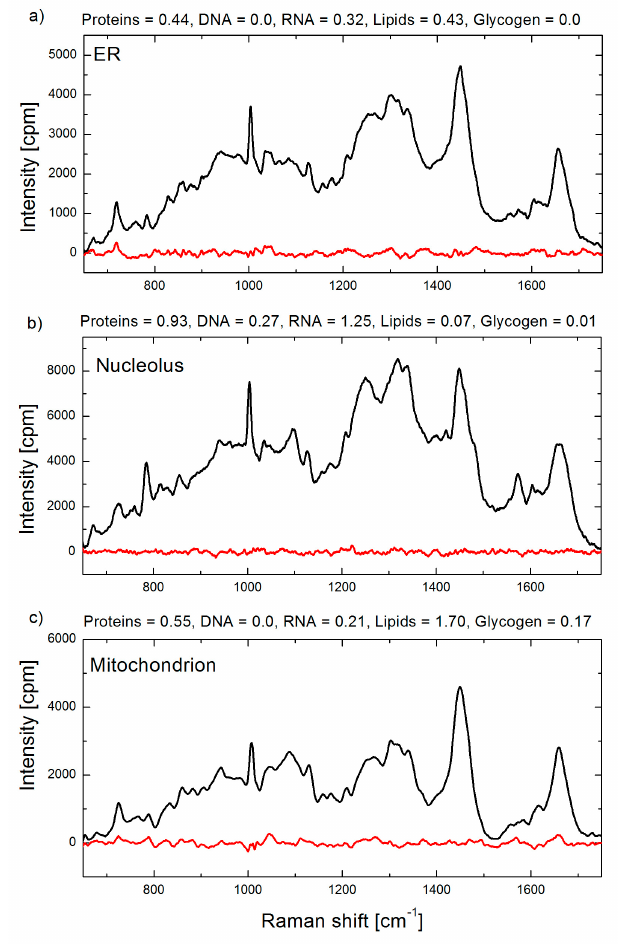
Figure 4. Raman spectra of a single organelle: ( a ) endoplasmic reticulum; ( b ) nucleolus; and ( c ) mitochondrion in live HeLa cells. Raman spectra are shown in black and corresponding residual spectra obtained by BCA procedure are shown in red. Biomolecular weights obtained by BCA are indicated in arbitrary units, which for this example correspond to 100 mg/mL for proteins, and 20 mg/mL for DNA, RNA, lipids and saccharides, respectively.